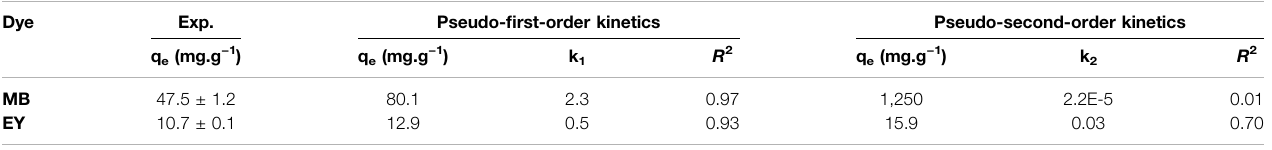
TABLE2| TheadsorptionparametersofMBandEYbyHCl-treatedp(APTMACl-co-AMPS)-3hydrogelsfromtheLangmuir,Freundlich,Temkin,andDubinin-Radushkevich isotherms. Dye Exp.